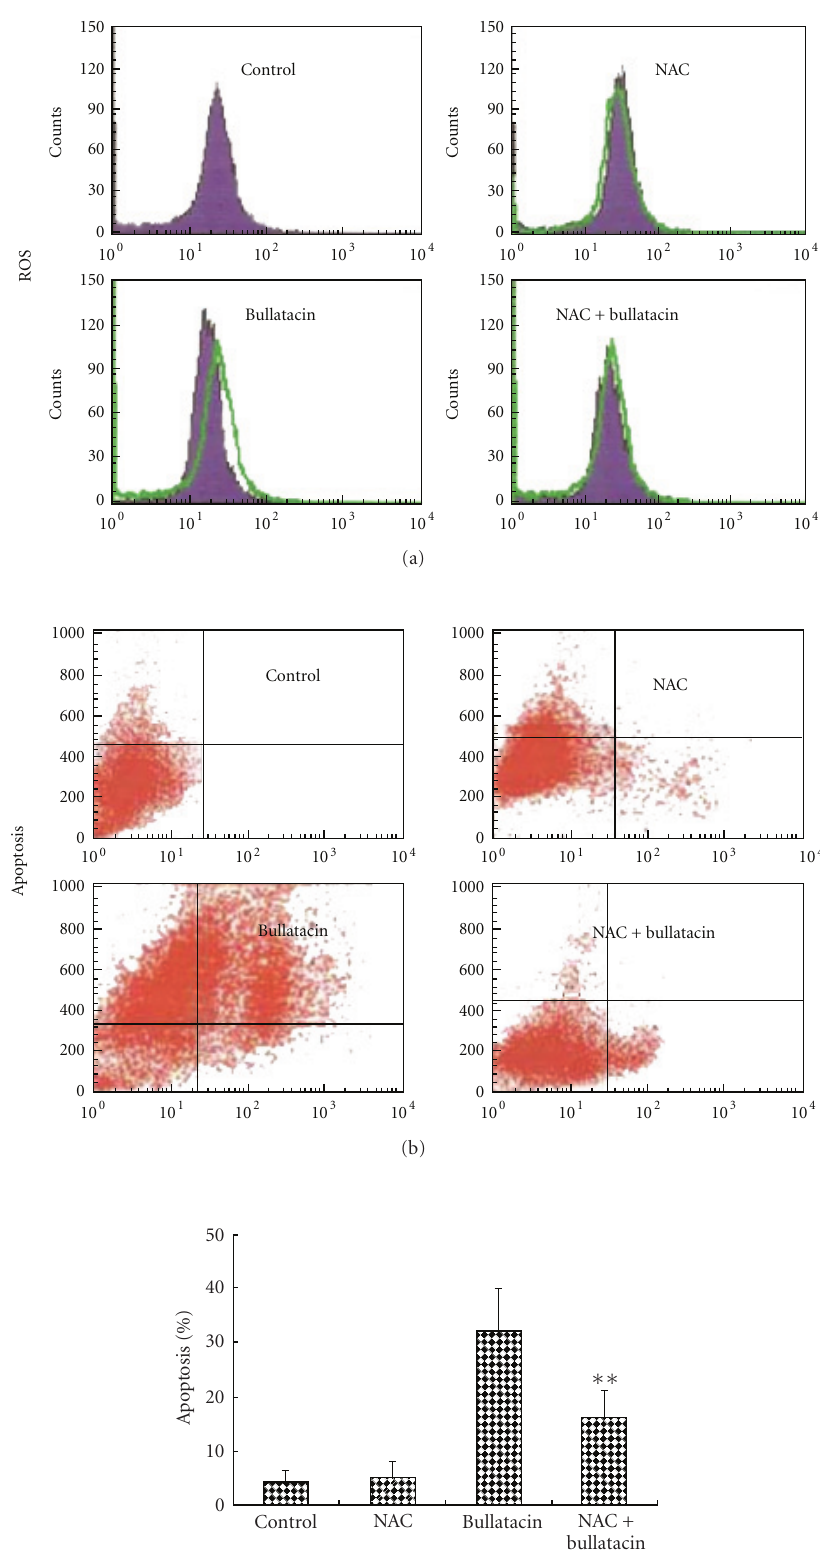
Figure 4: E ff ect of antioxidant molecules N-acetyl-l-cysteine (NAC) on ROS generation (a) and cell apoptosis (b) induced by bullatacin in KBv200 cells. KBv200 cells pretreated with 1mmol/L NAC for 4 hours and then exposed to 10 nmol/L bullatacin for 48 hours, ROS generation and cell apoptosis were examined. The experiments were performed three times and a representative experiment is